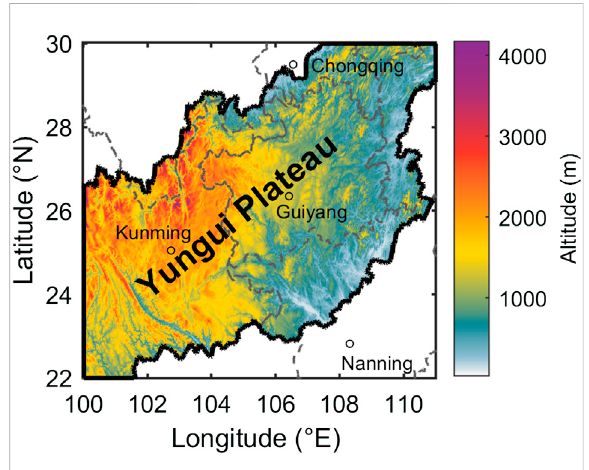
FIGURE 1 The region of interest (marked by the black line) selected in the study: Yungui Plateau (100 ° – 111 ° E, 22 ° – 30 ° N). The provincial boundariesare marked byadotted gray lineand thecapitalsofthe provinces are